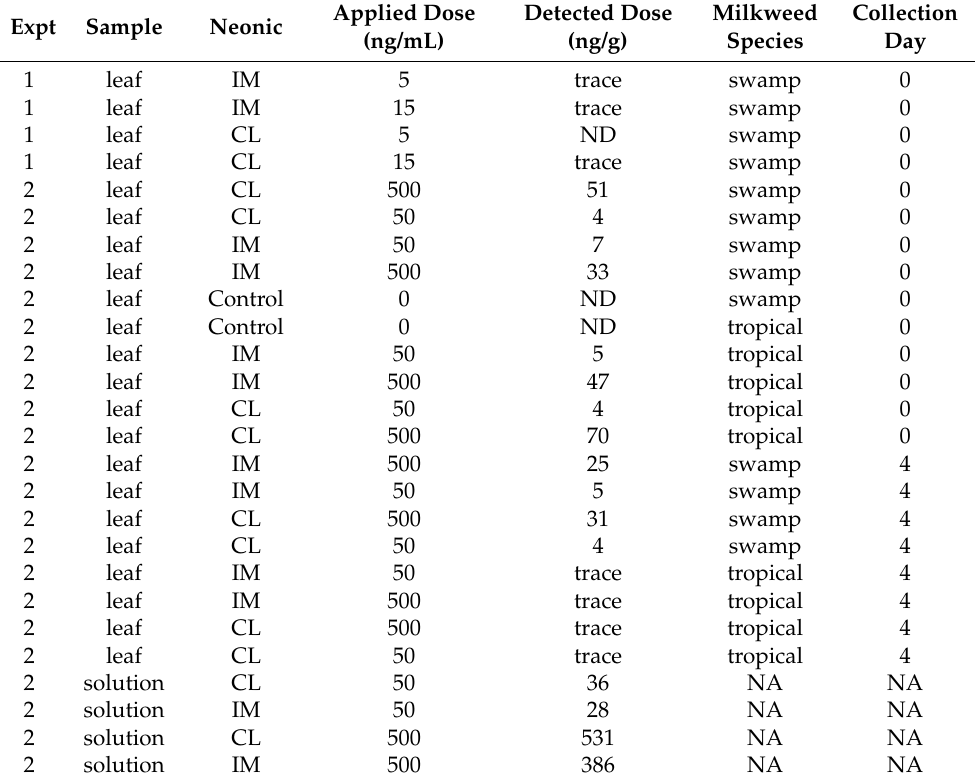
Table 1. Residue of neonicotinoids detected in leaves (Experiments 1 and 2) and solutions (Experiment 2) relative to applied dose. Leaves were stored and shipped frozen for residue analysis to the USDA, AMS lab, Gastonia, NC. IM = Imidacloprid, CL = Clothianidin, ND = not detected, NA = not applicable. Limits of detection were: 3 ng/g CL and 2 ng/g